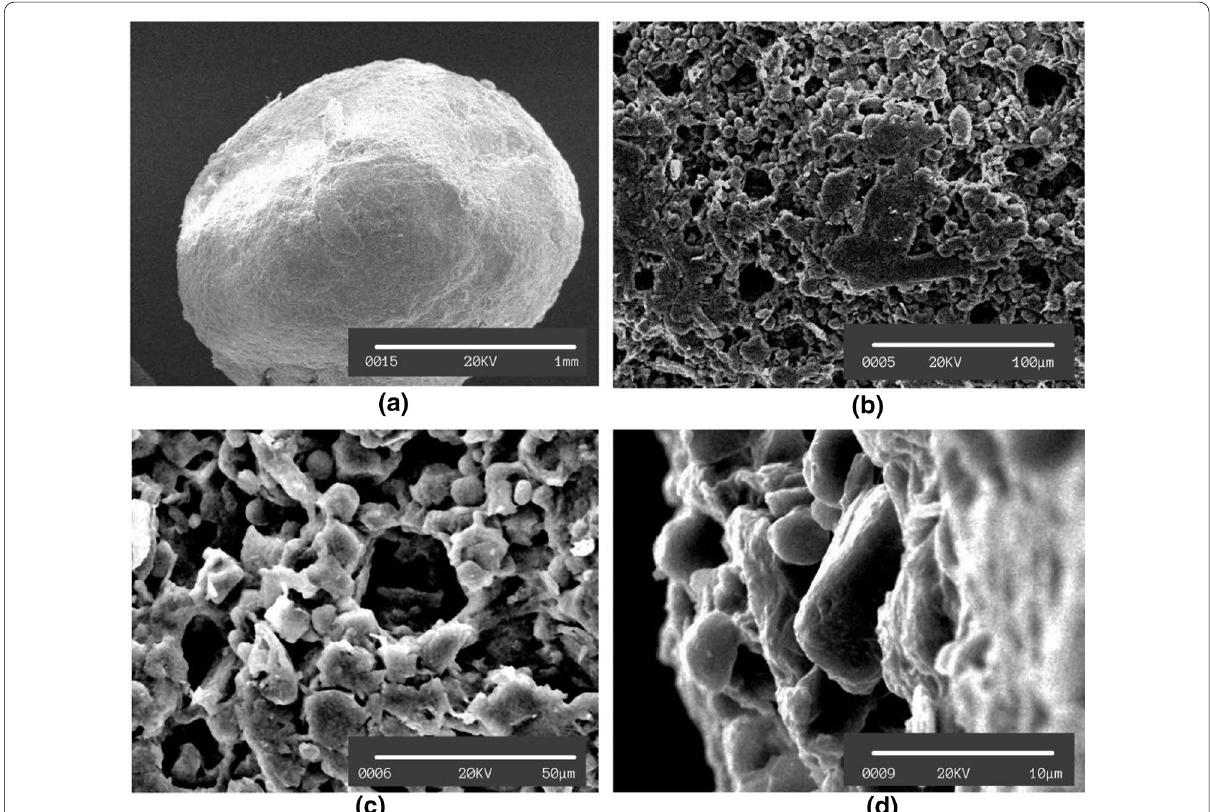
Fig. 3 Scanning electron microscopy (SEM) of optimized satranidazole pellet a before dissolution study, b surface topology before dissolution study, c after dissolution study and d cross-section of reservoir pellets (coating layer)